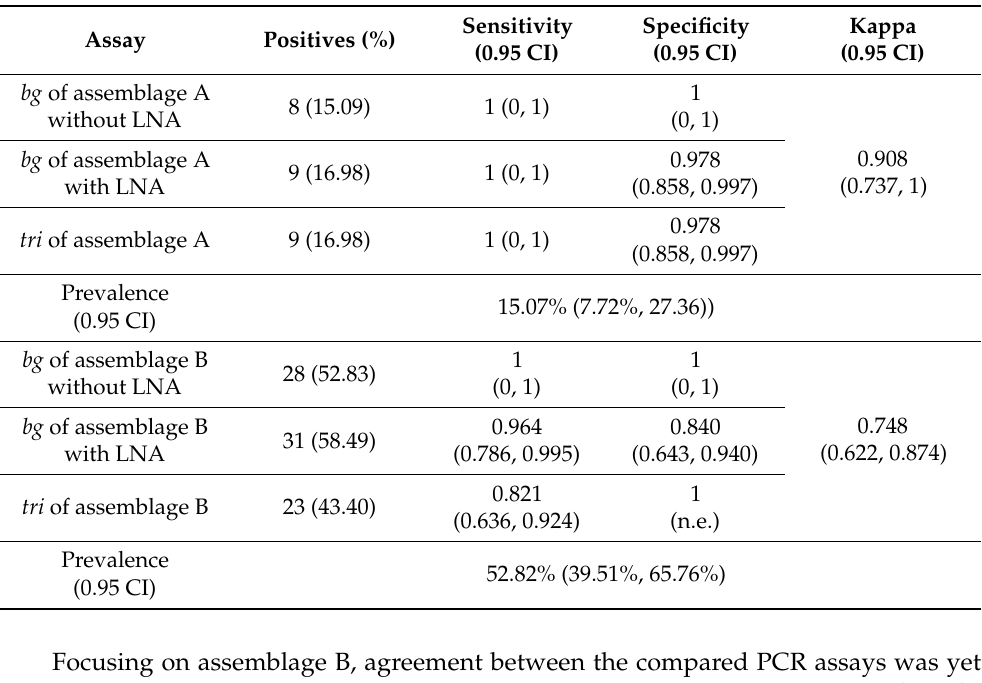
Table 2. Agreement kappa between the compared real-time differentiation PCR assays targeting the G. duodenalis assemblages A and B as well as sensitivity, specificity, and accuracy-adjusted prevalence as calculated with latent class analysis (LCA) based on the assessment of n = 53 non-inhibited samples testing positive in at least two of the different G. duodenalis screening